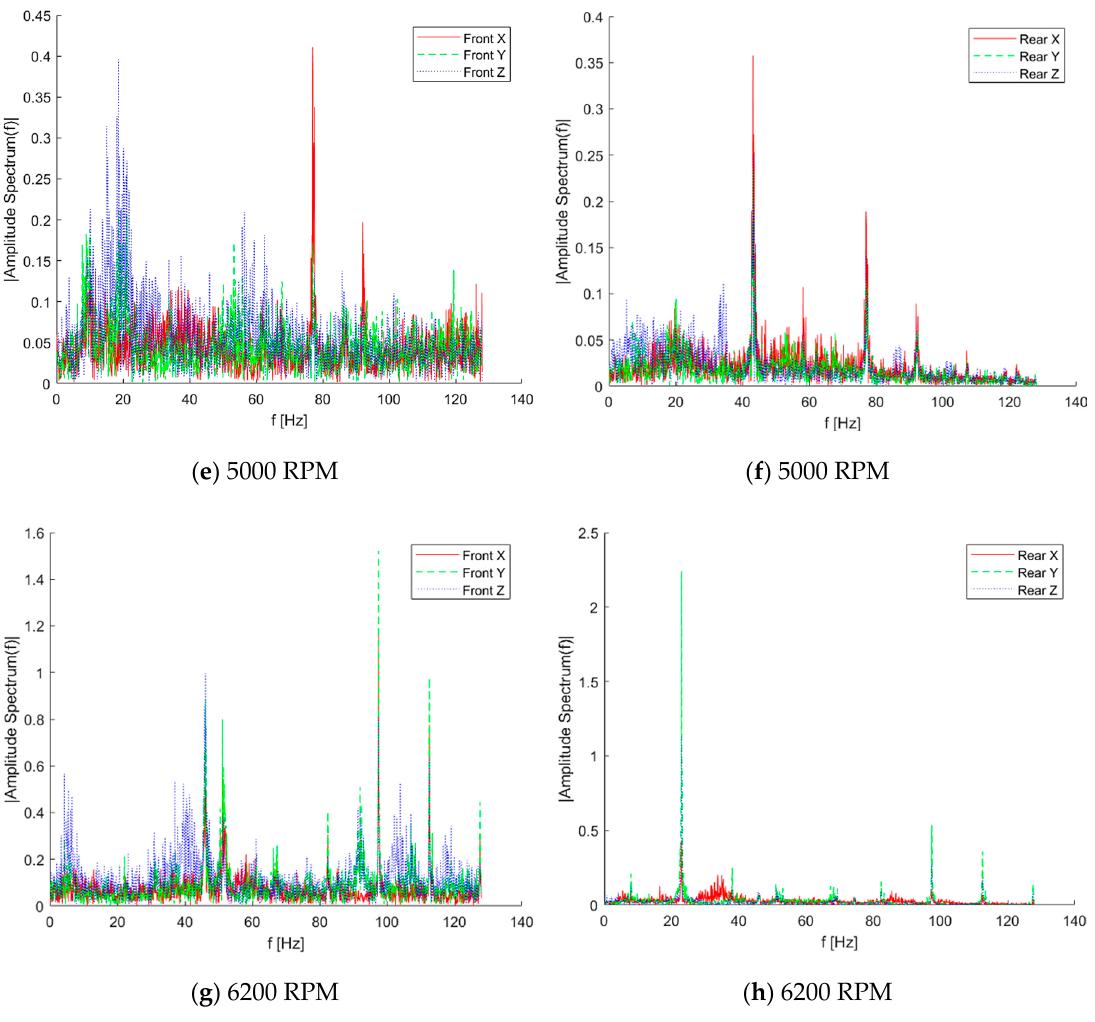
Figure 24. 3-axes acceleration for selected engine speed for sensor ( a ) front – 2800 RPM ( b ) rear – 2800 RPM ( c ) front – 3900 RPM ( d ) rear – 3900 RPM ( e ) front – 5000 RPM ( f ) rear – 5000 RPM ( g ) front – 6200 RPM ( h ) rear – 6200 RPM.